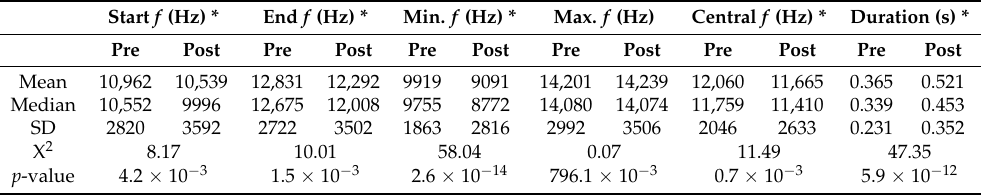
Table 3. Whistle characteristics before and after detonation and statistical comparisons.